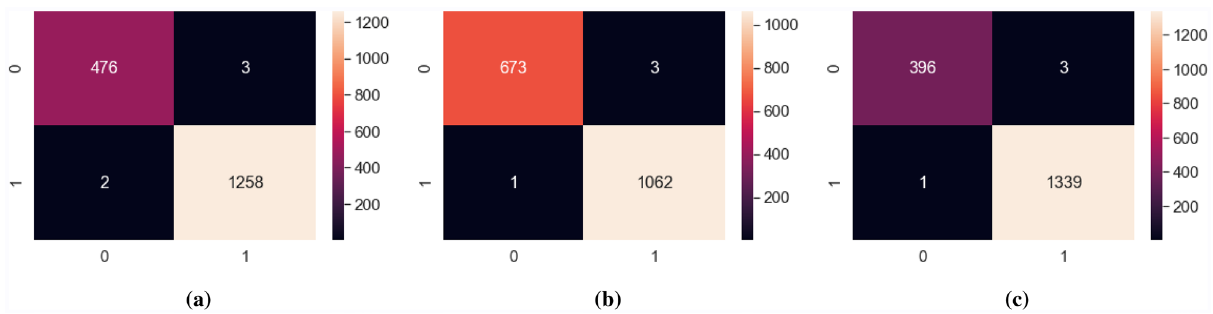
Figure 12. Confusion matrix of ( a ) arousal, ( b ) valence and ( c ) dominance of the proposed spectrogram image based CNN-XGBoost fusion